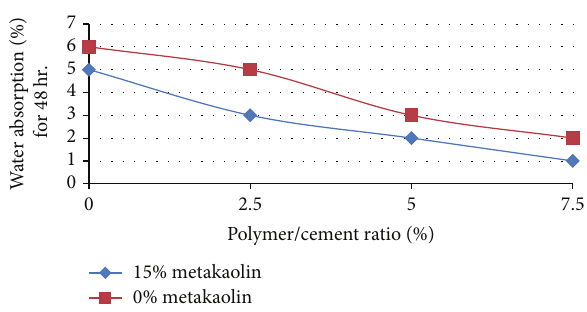
Figure 15: Water absorption at different polymer contents.